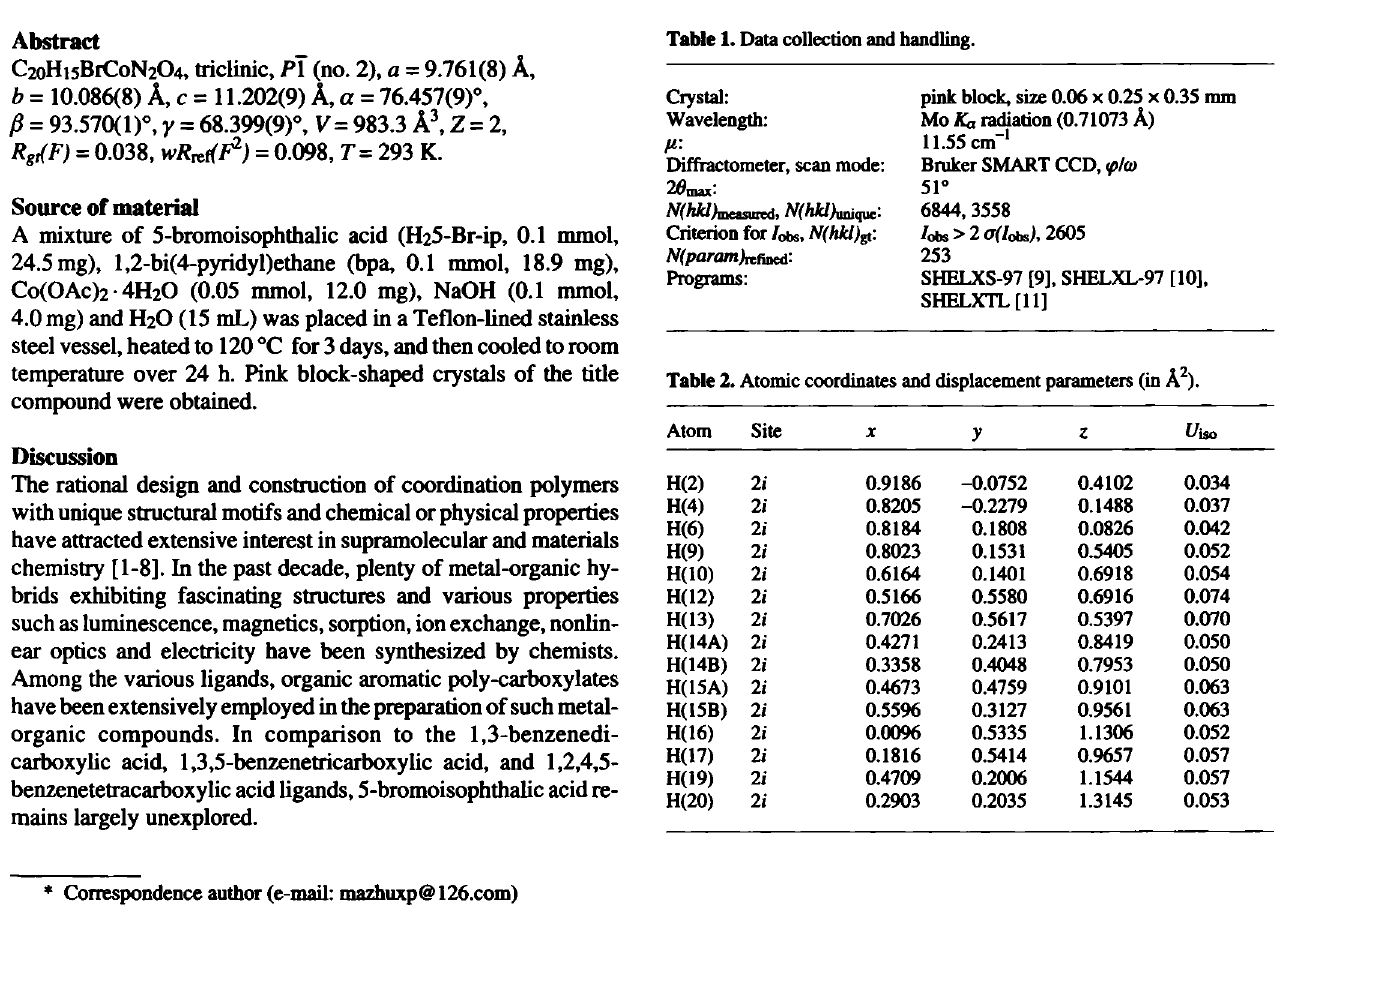
Table 1. Data collection and handling.